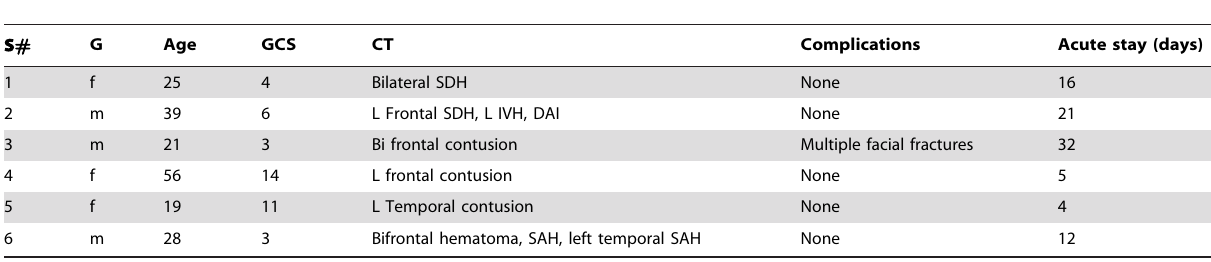
Table 3. Demographic, clinical and behavioral data for the subjects with